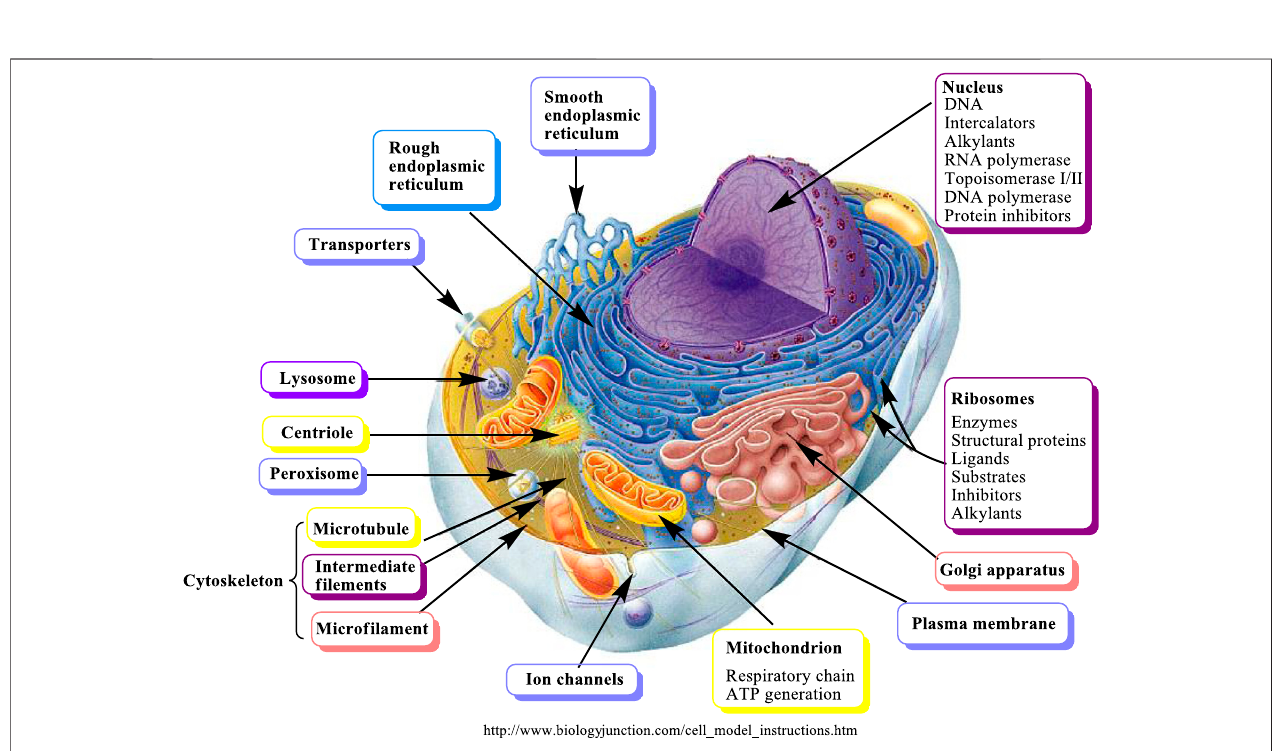
FIGURE 3 | Molecular targets of secondary metabolites modi fi ed from (Wink, 2007).